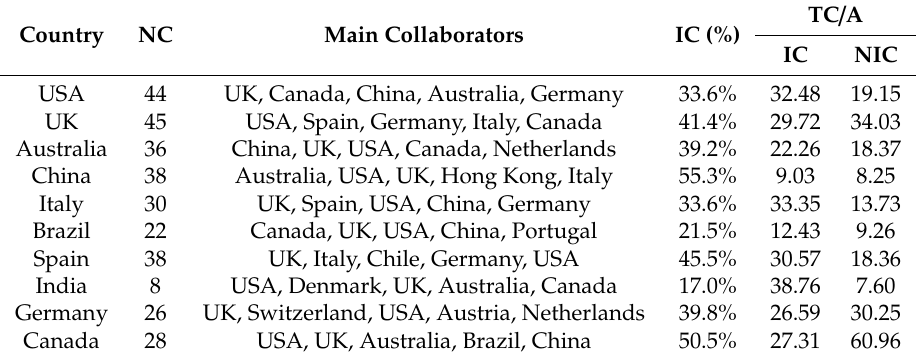
Table 7. Top 10 prolific countries and international collaboration